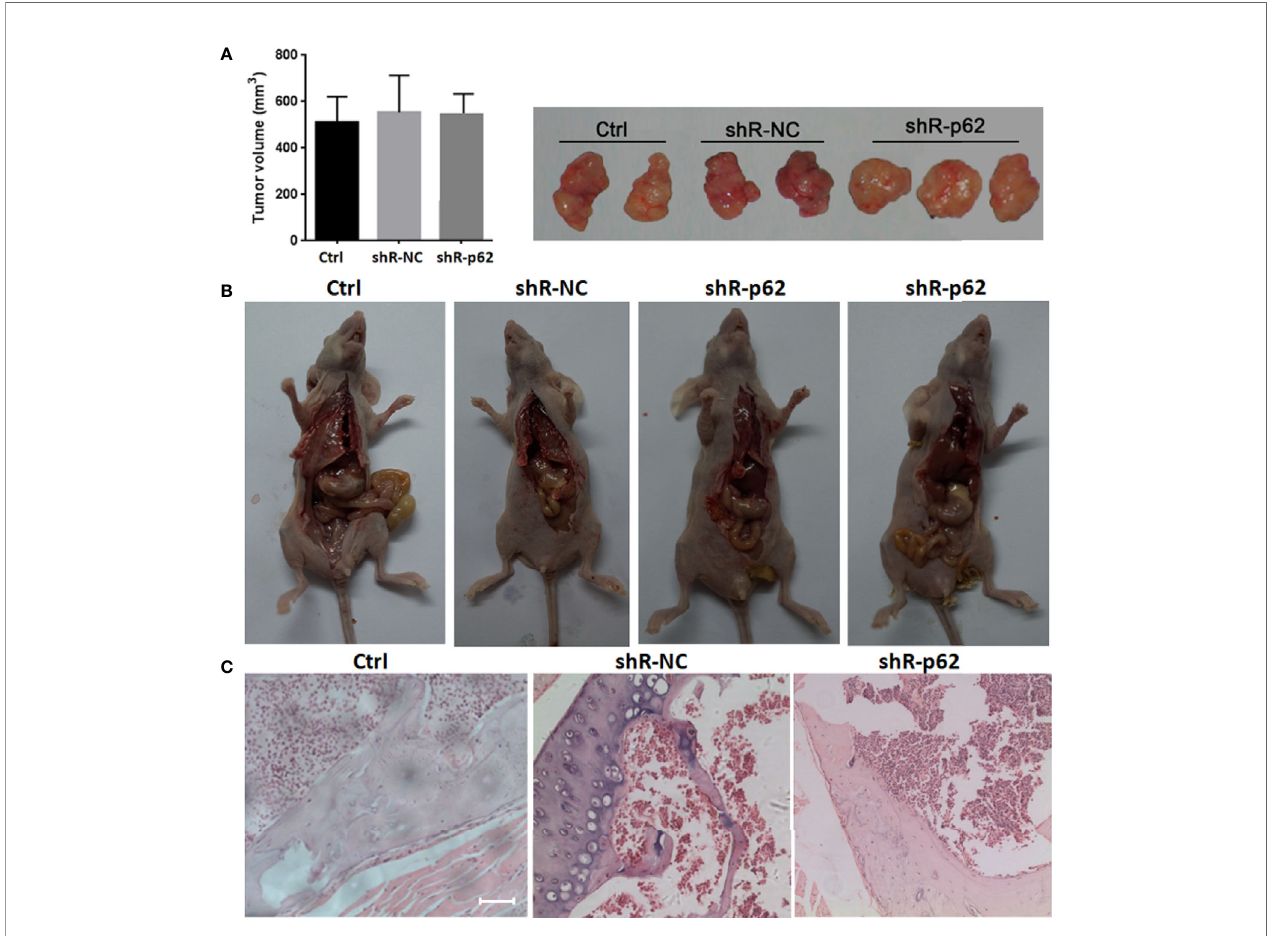
FIGURE 5 | In vivo p62 downregulation had no effect on growth of subcutaneous tumor. (A) The difference of tumor volumes between silenced p62 group (n = 3), scrambled control group (n = 2) and control group (n = 2) was not statistically signi fi cant. (B) All mice model was dissected on the 28th day, and lung or bone metastasis lesion was not found. (C) Bone metastasis lesion of limb or spine was not found under microscope (scale bar 200µm). Ctrl, untreated A549 cells; shR- p62, stably transfected A549 cells; shR-NC, shR-p62 scrambled